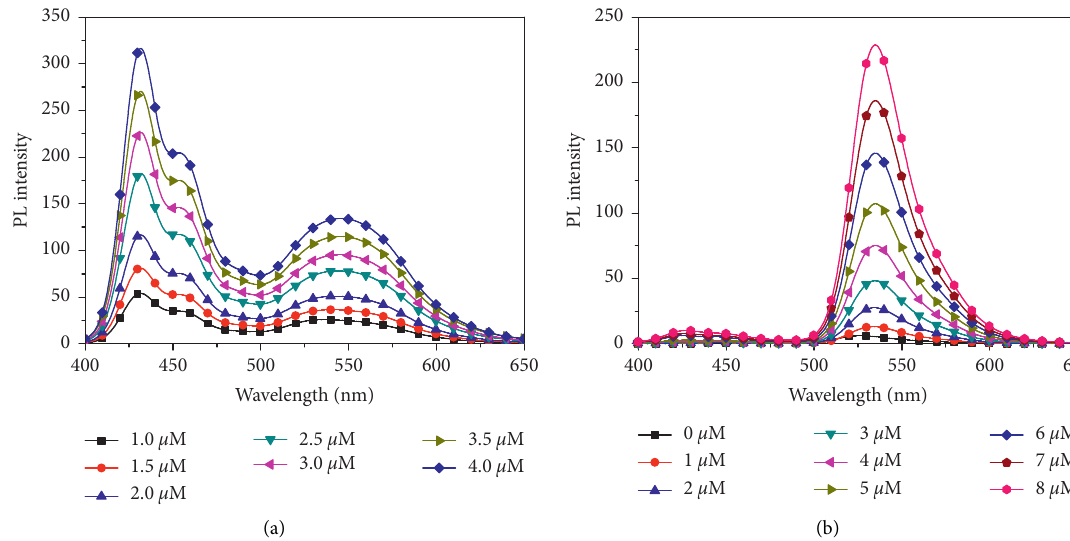
Figure 10: (a) The emission spectrum of P4/ssDNA-FAM solution upon increasing of [P4]. (b) The emission spectrum of P2/ssDNA-FAM solution upon increasing of [P4 ′ ] (excitation at 384nm).